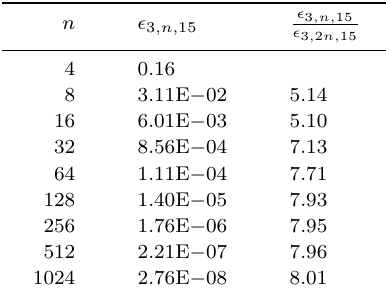
Table 5. m = 2, p = 9, λ 0 = λ 1 = 0 . 25. Table 6. m = 3, p = 15, λ 0 = λ 1 = 0 . 25.